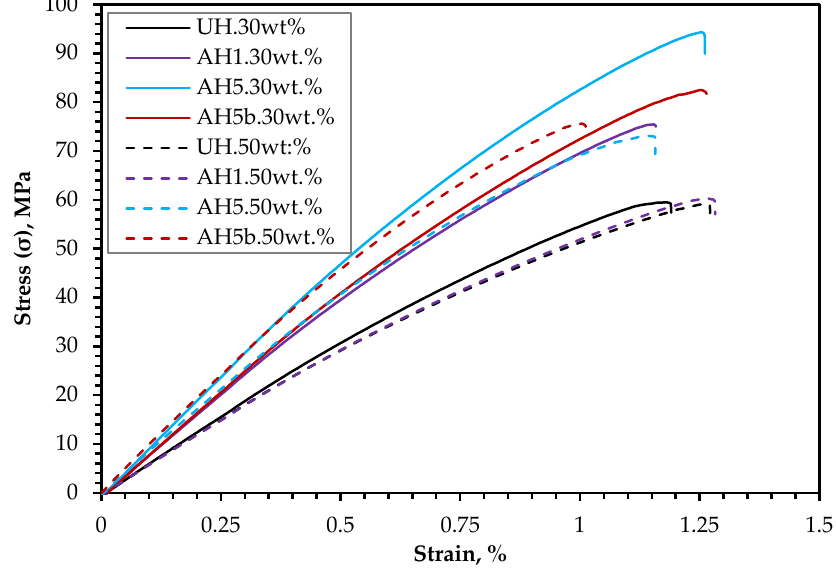
Figure 8. Stress–strain curves of the biocomposites at 30 (–) and 50 wt.% (- -) fiber content.